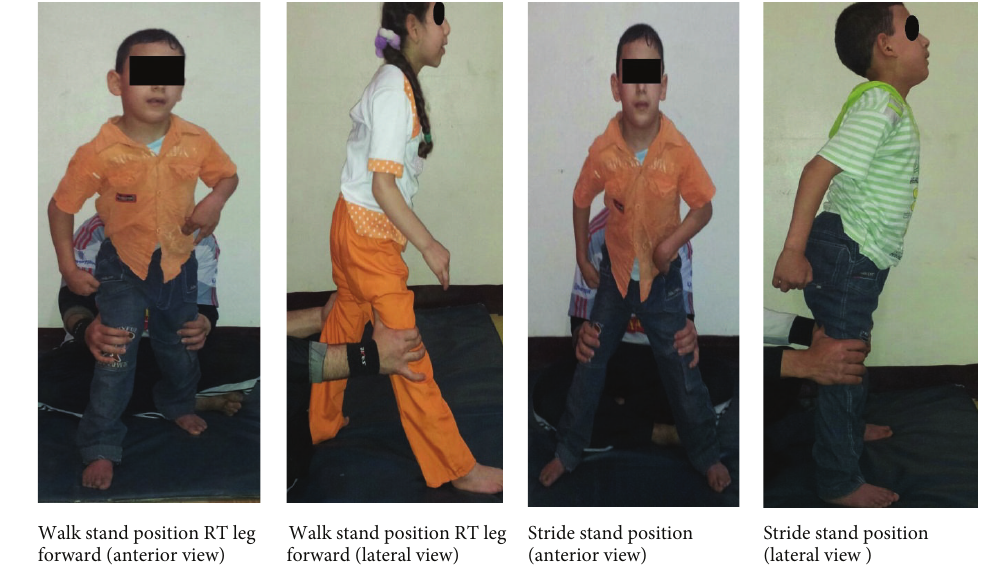
Figure 1: Illustration of walk stand and stride stand positions. Table 2: Pretreatment comparison between right and left sides in each group.